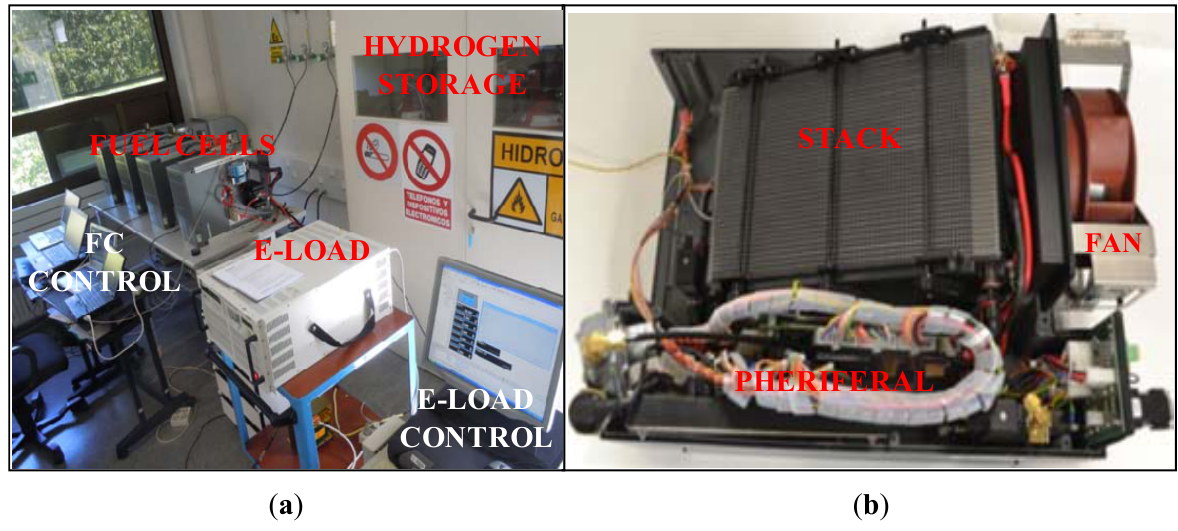
Figure 1. ( a ) Photo of the hydrogen laboratory: 4 PEMFCs, hydrogen storage and programmable electronic load (E-LOAD); ( b ) Photo of the interior of one of the